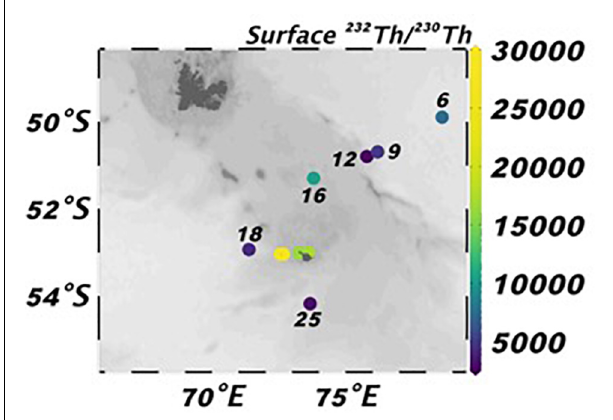
FIGURE 8 | Spatial distribution of the surface 232 Th/ 230 Th ratio over the plateau.